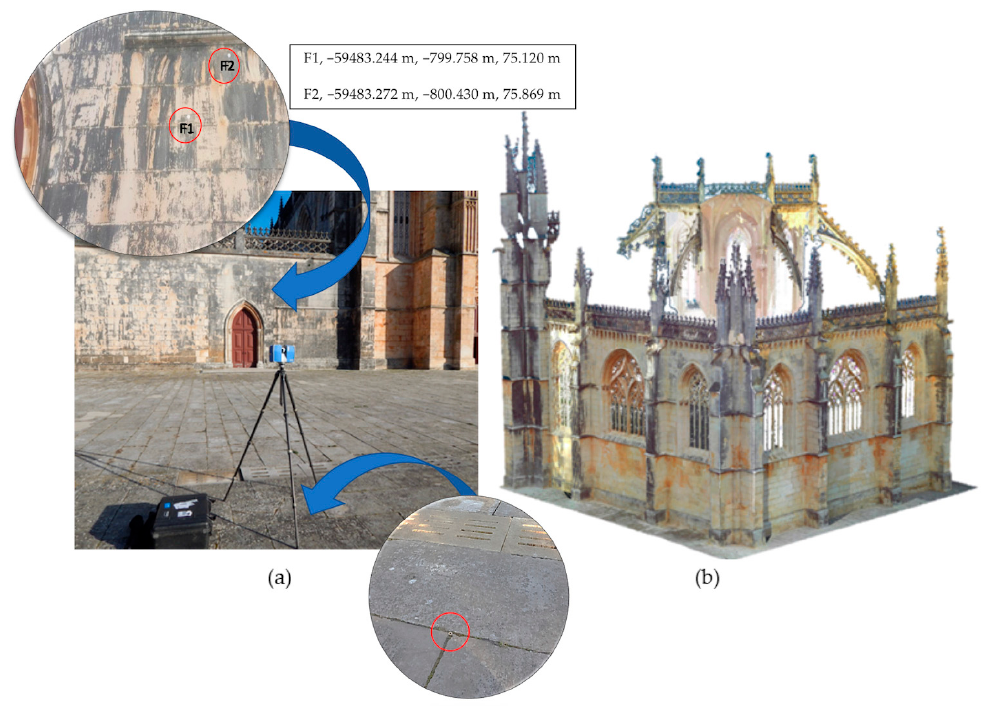
Figure 6. ( a ) Faro Focus 3D X330 during data acquisition, and ( b ) Founder’s Chapel point clouds after registration.